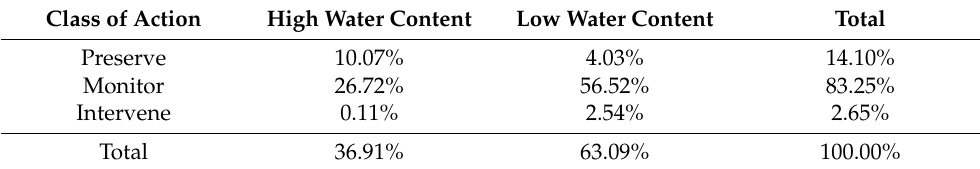
Table 15. Distribution of Water Content category per IUHI class of action based on NDWI. Class of